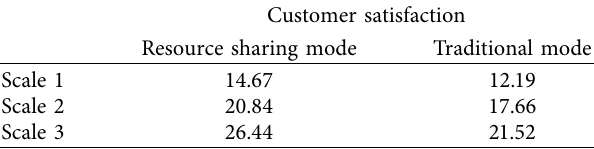
Table 6: Customer satisfaction